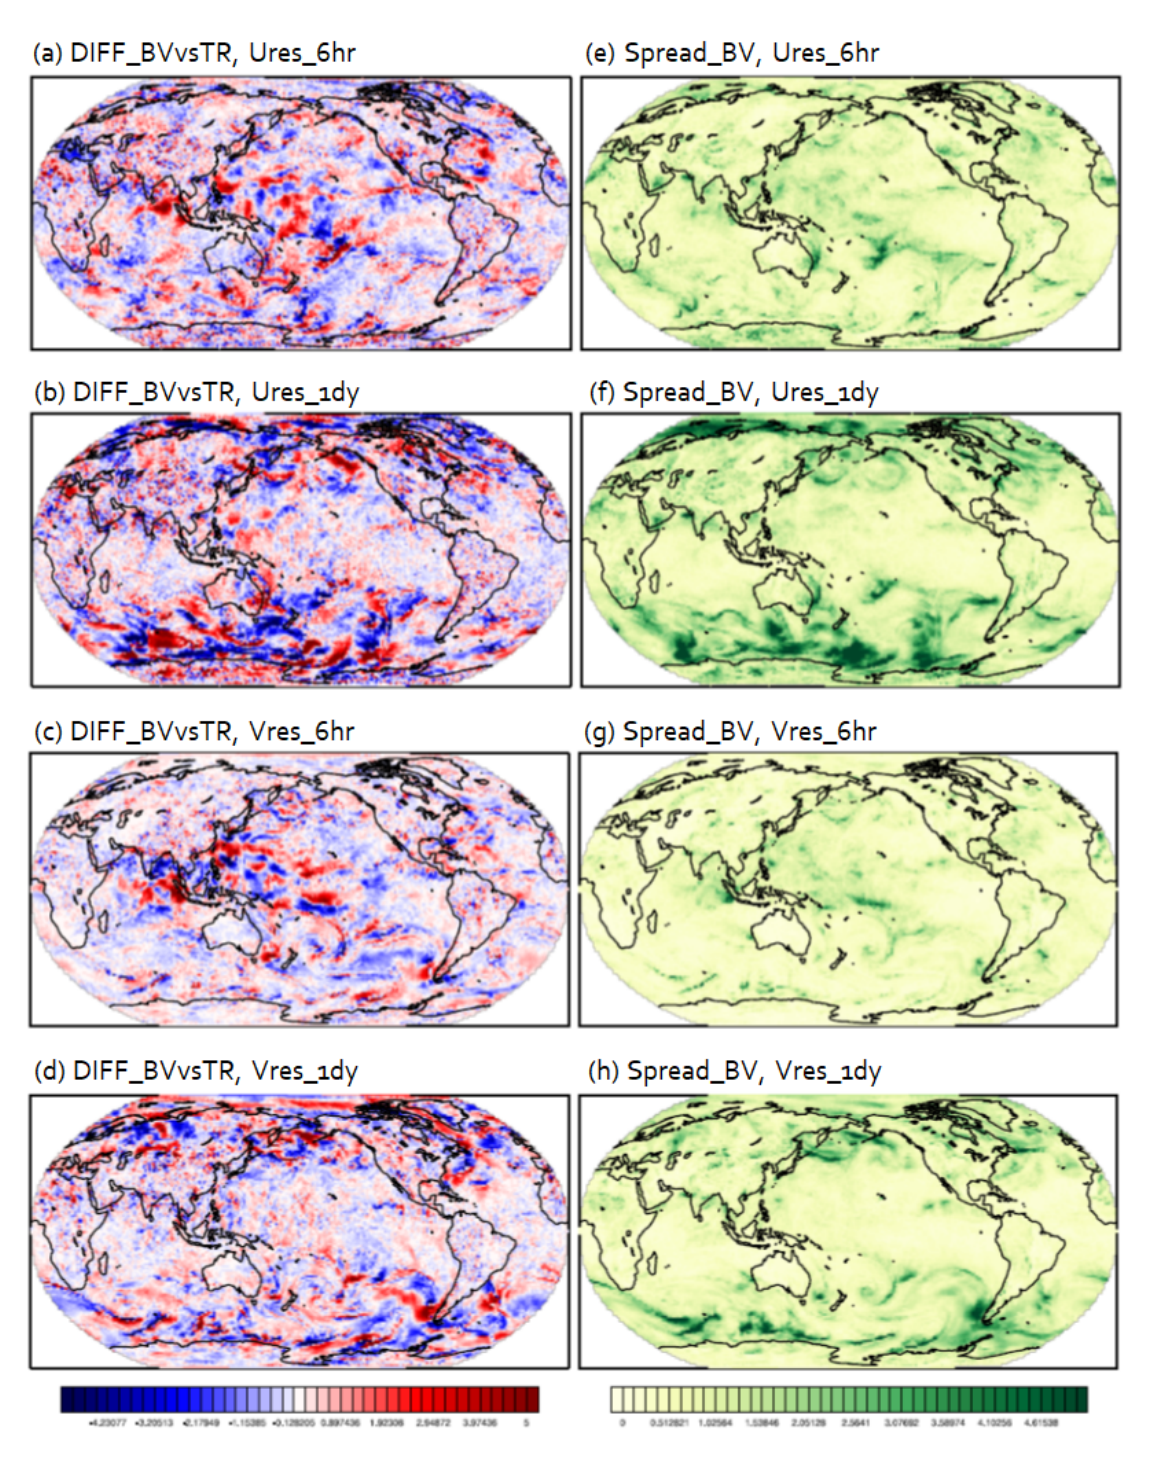
Figure 4. Difference of the mean bred vectors from the nature ( a – d ) and the spread of bred vectors ( e – h ) of surface zonal wind from the experiments of Ures_6hr ( a,e ), Ures_1dy ( b , f ), Vres_6hr ( c , g ), and Vres_1dy ( d , h ), valid at 00UTC on 10 August